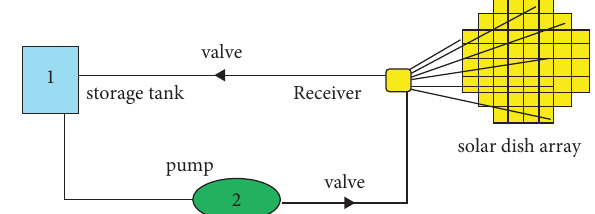
Figure 5: Schematic connection of